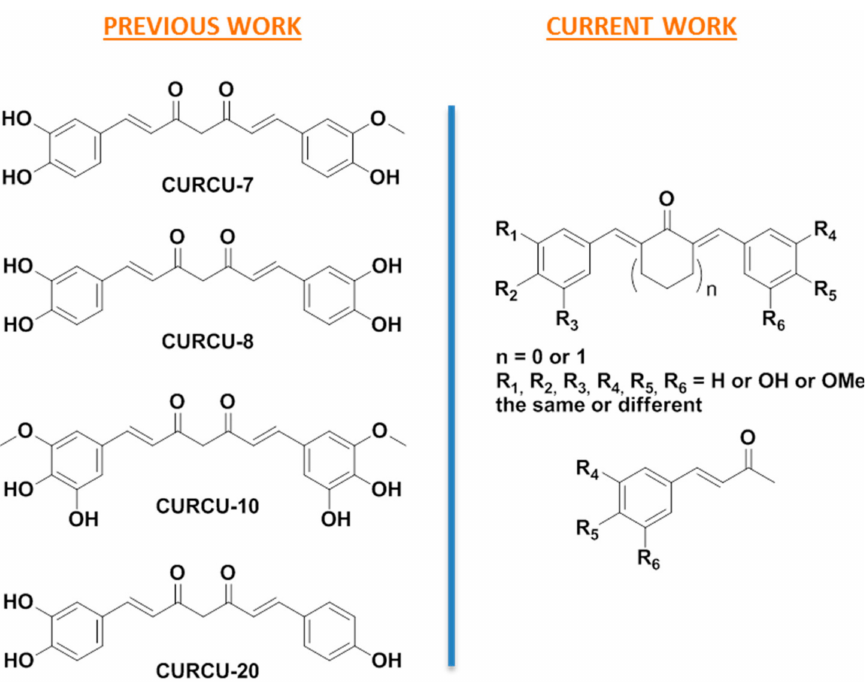
Figure 2. The schematic representation of the design of this work based on previous reports